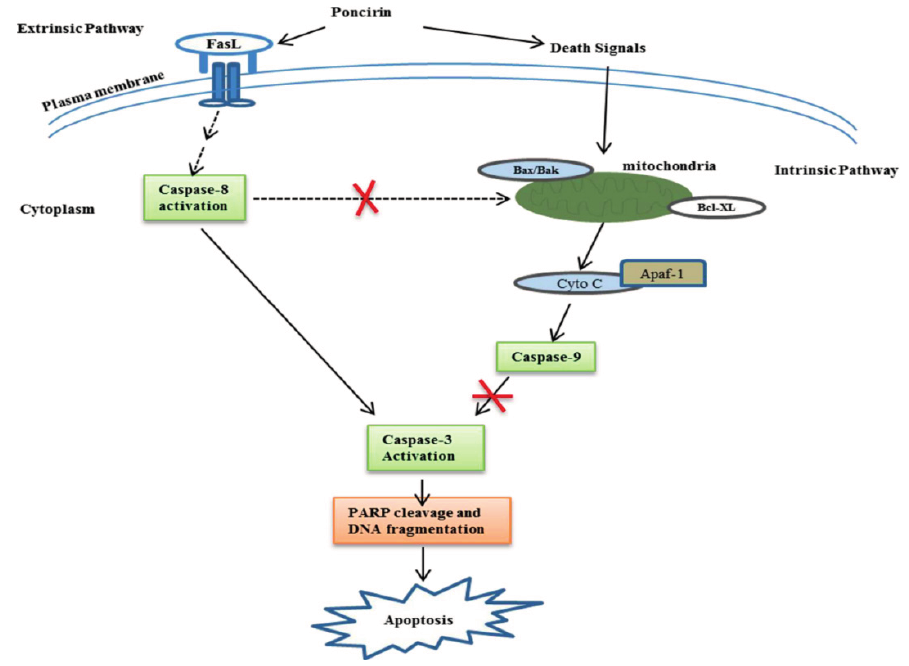
Figure 7. Schematic diagram showing the mechanisms underlying the anti-cancer effects of Poncirin. Poncirin induced apoptosis by up-regulating FasL, and then activated caspase-8 and -3, which subsequently activated cleavage of PARP and DNA fragmentation. Poncirin does not alter MMP ( ΔΨ m) and mitochondrial regulatory proteins in AGS cells. Taken